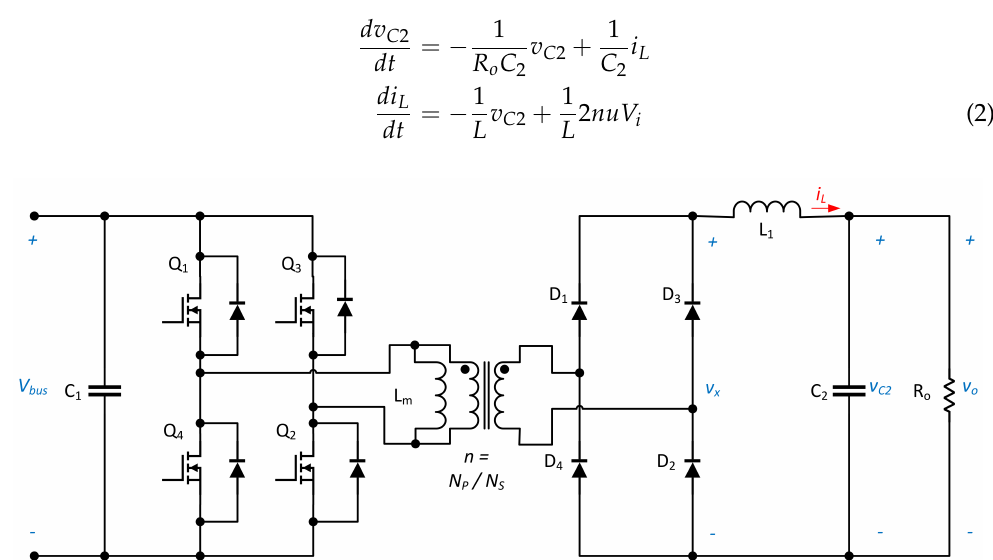
Figure 3. DC-DC Full Bridge Converter.